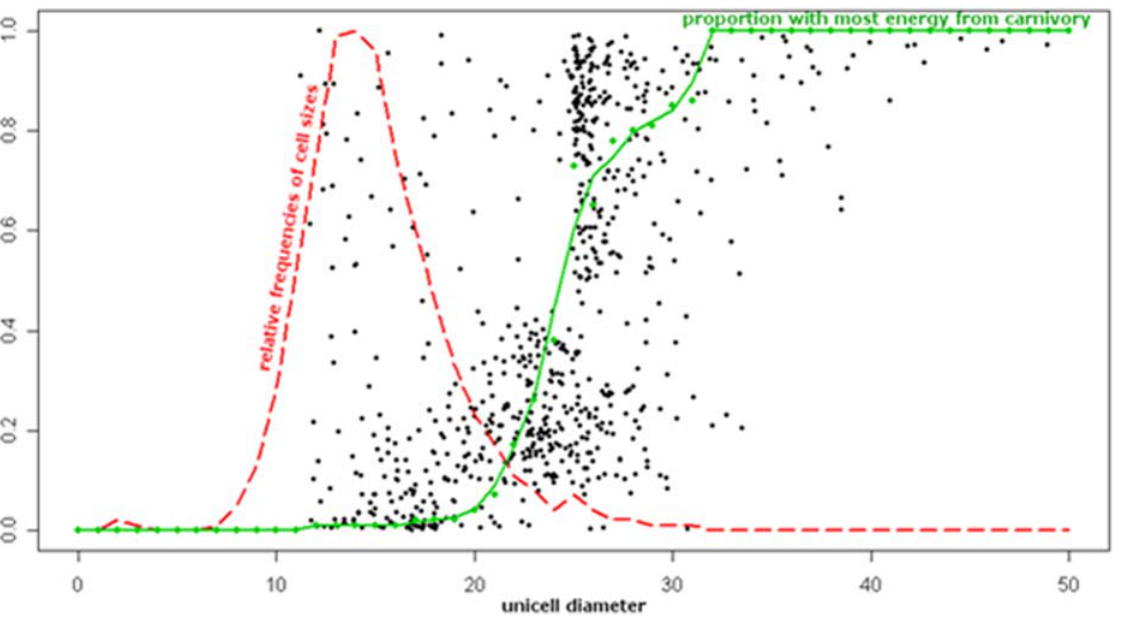
Figure 2. Proportion of energy derived from predation. The dashed red line shows the relative proportion of unicells in each size class; the large majority of unicells are in the 10–20 range. Black dots are the proportion of energy derived from predation for the , 4% of individual unicells that have obtained some food from predation. (Not shown separately are the vast majority of unicells, , 96%, that have derived all their energy from primary production.) The green solid line is the fraction of unicells in each size class that have derived the majority of their energy from predation. Only the rare cells larger than about 24 units obtain most of their energy from predation. Parameters and conditions are described in Supplementary Information, table 2.